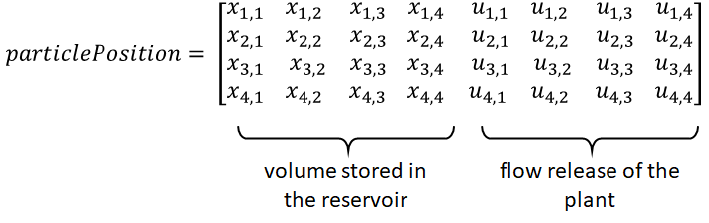
Figure 4. Position of the particle in the Network Flow (NF) + Particle Swarm Optimization